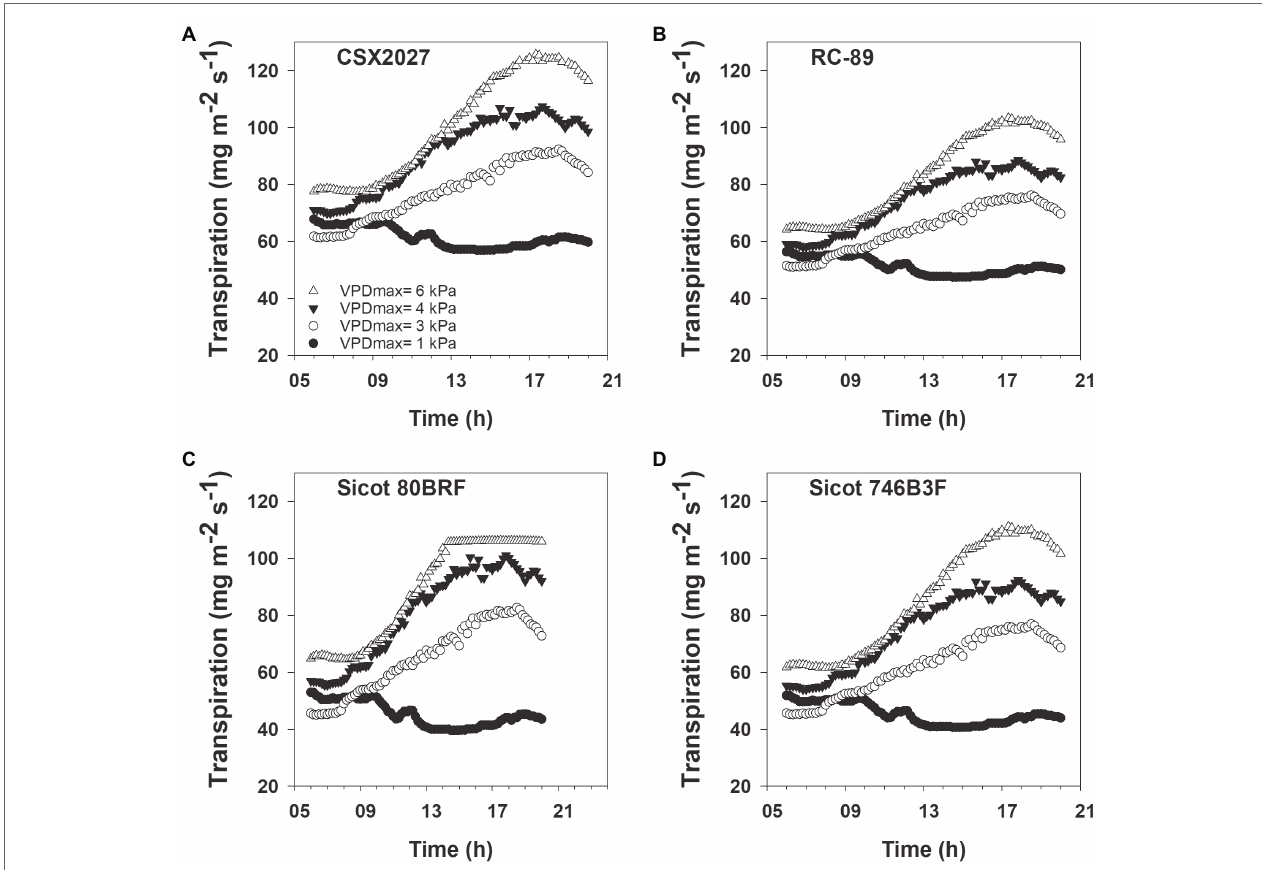
FIGURE 2 | Four cotton genotypes (A) CSX2027, (B) RC-89, (C) Sicot 80BRF, and (D) Sicot 746B3F, with differing transpiration responses to representative VPD conditions in Narrabri NSW from sunrise to sunset (6 am to 8 pm;